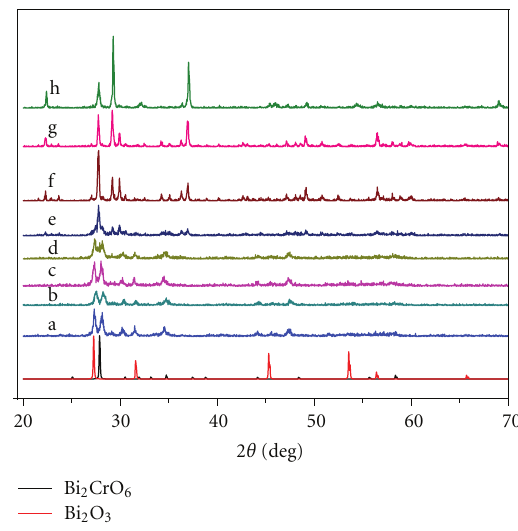
Figure 6: Photodecomposition of MB dye in solution (20mg/L) over Bi 2 O 3 -Bi 2 CrO 6 composite nanowires, commercial available Bi 2 O 3 and fabricated Bi 2 O 3 , under visible-light irradiation ( λ ≥ 400nm). C is the concentration of MB dye at time t , and C 0 is the original concentration before it is irradiated.